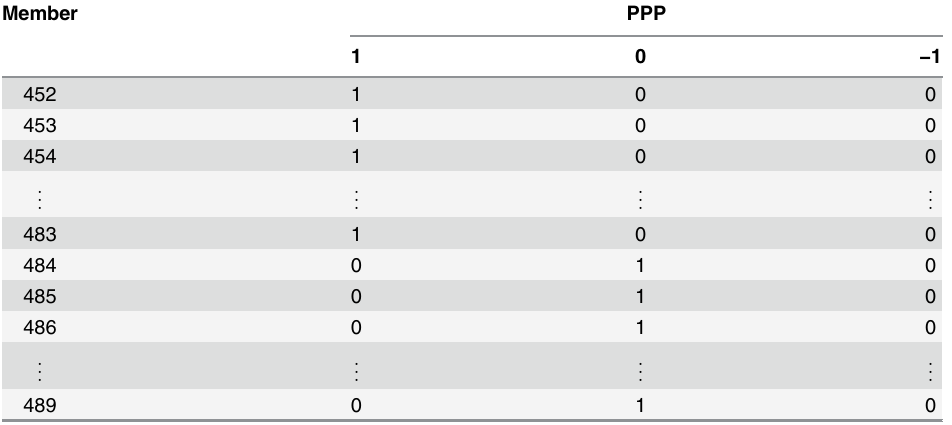
Table 17. A decomposition of Table 10 into multi-tables of Boolean-Valued for PKB. Member PKB 1 0 − 1 490 1 0 0 491 1 0 0 492 1 0 0 . .. . .. . .. . .. 497 1 0 0 498 0 1 0 499 0 1 0 500 0 1 0 . .. . .. . .. . .. 517 0 1 0